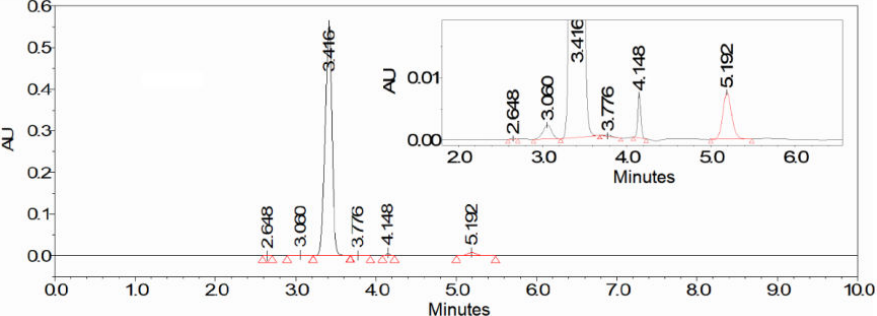
Figure 2. Chromatogram of the synthesized α -ketoglutaramate (HPLC-system: Waters 1525 Binary HPLC Pump, Waters 2489 UV/Visible Detector, Waters 2707 Autosampler; analysis conditions are specified in Section 3.3). Retention times: L-glutamine—2.65 min ( ≤ 0.05%), α -ketoglutaramate— 3.42 min ( ≥ 97%), α -ketoglutarate—3.78 min (~0.03%), 5-oxoproline—5.19 min (~1.2%). Other peaks are unidentified impurities ( ≤ 1.5%).